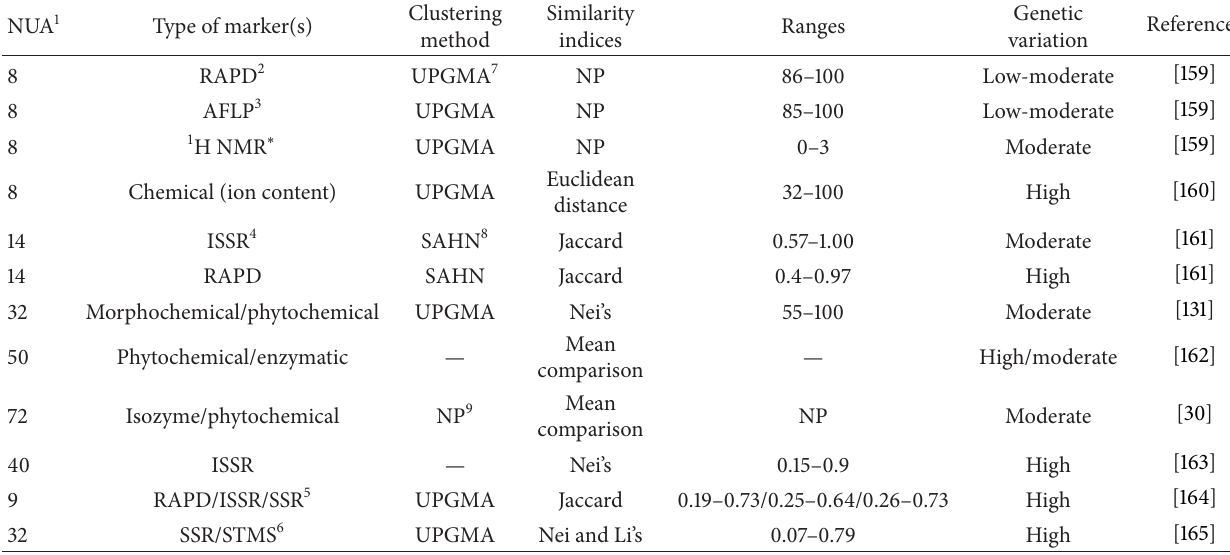
Table 2: Genetic diversity in Catharanthus roseus accessions using different marker systems.